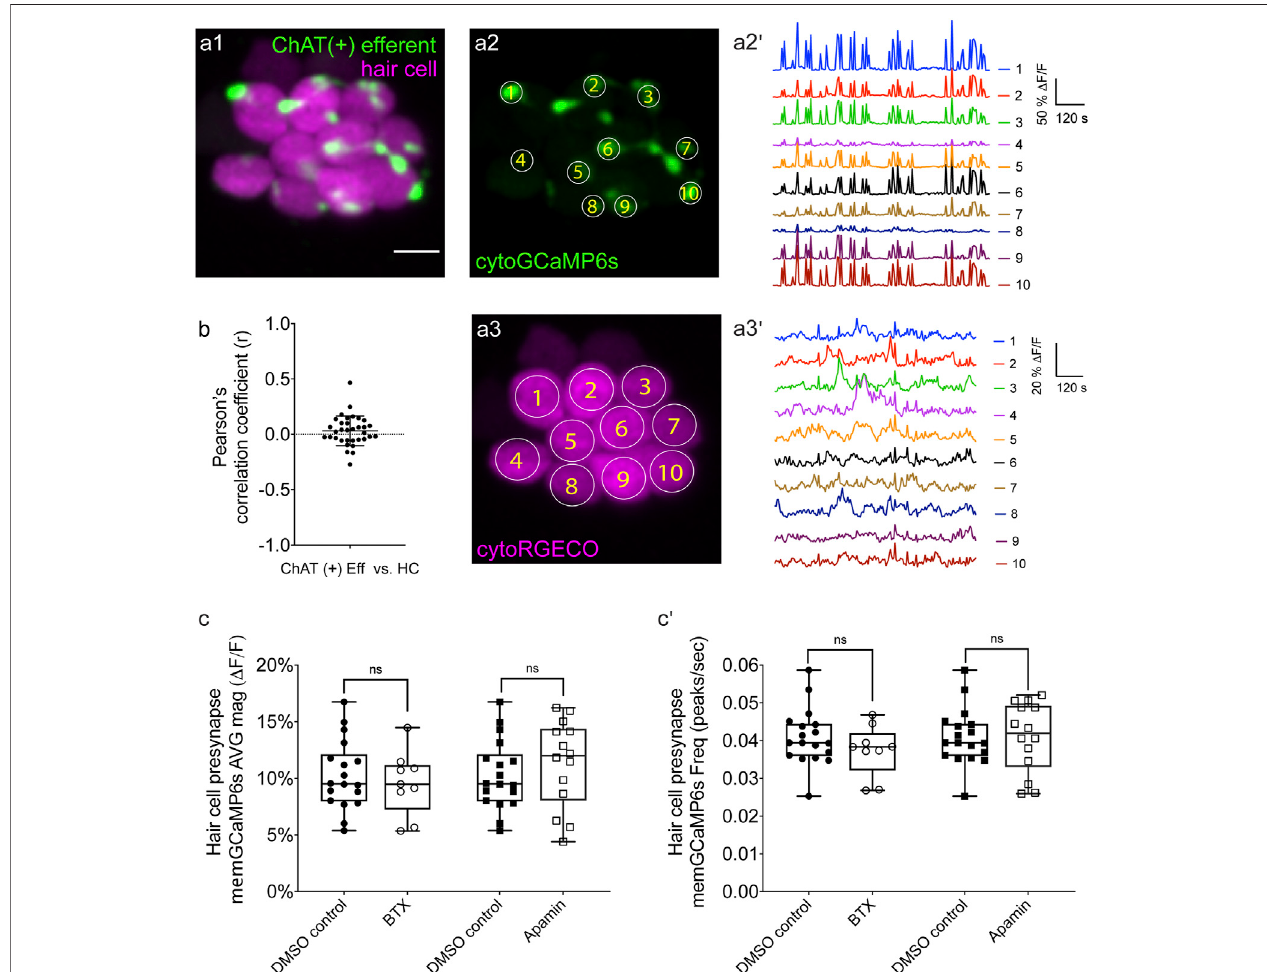
FIGURE 3 | Two-color imaging of spontaneous activities in hair cells and cholinergic efferent terminals. (A1) A representative Max-projection image of a double- transgeniczebra fi shlineexpressingtheredGECIcytoRGECO1inhaircellsandthegreenGECIcytoGCaMP6s inthecholinergicefferentsterminalsatday3. (A2) Image depictingcholinergicefferent terminalswithindividualterminalscontactingdifferenthaircellsin (A1) arelabeledaccordingly. (A2 9 ) Thecorrespondingtemporalcurvesof spontaneous calcium activities of the 10 efferent terminals indicated in (A2) . (A3) Image of the individual hair cells in a1 labeled according to innervating efferent terminal. (A3 9 ) Thecorrespondingtemporalcurvesofspontaneouscalciumactivitiesofthe10haircellsindicatedin (A3) . (B) Pearson ’ sRvaluesofspontaneouscalcium activitybetweeneachhaircellanditscontactingcholinergicefferentterminal, n =34haircell-efferentterminalpairsfromfourneuromastsatday3.Boxplotsshowingthe average magnitude (C) and frequency (C ’ ) of spontaneous calcium activity at the hair cell presynapse in DMSO and after the treatment with 10 μ M α -Btx and 10 μ M apamin. Each point in (C – C 9 ) representsone neuromast. Allmeasurementswere performed inimmature neuromasts at day 3. Apaired t -test wasused in (C – C 9 ) . Scale bar = 5 μ